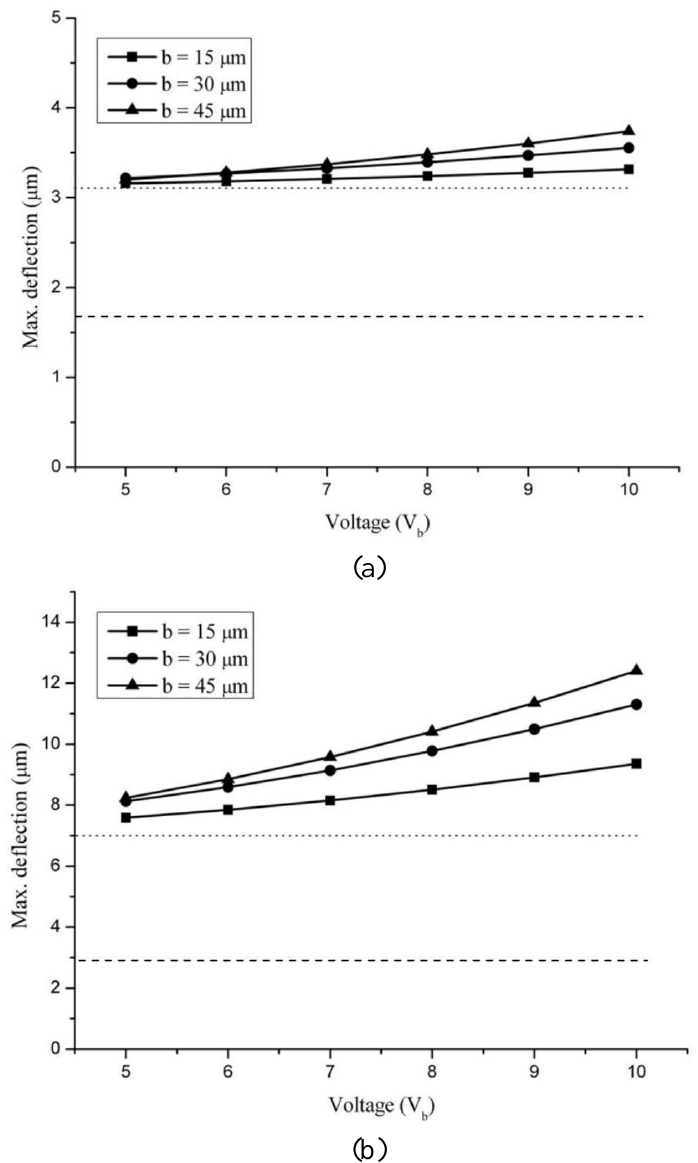
Figure 5. Effect of bias voltage on maximum deflections in silicon (a) and silicon dioxide (b) cantilevers of different piezoresistor